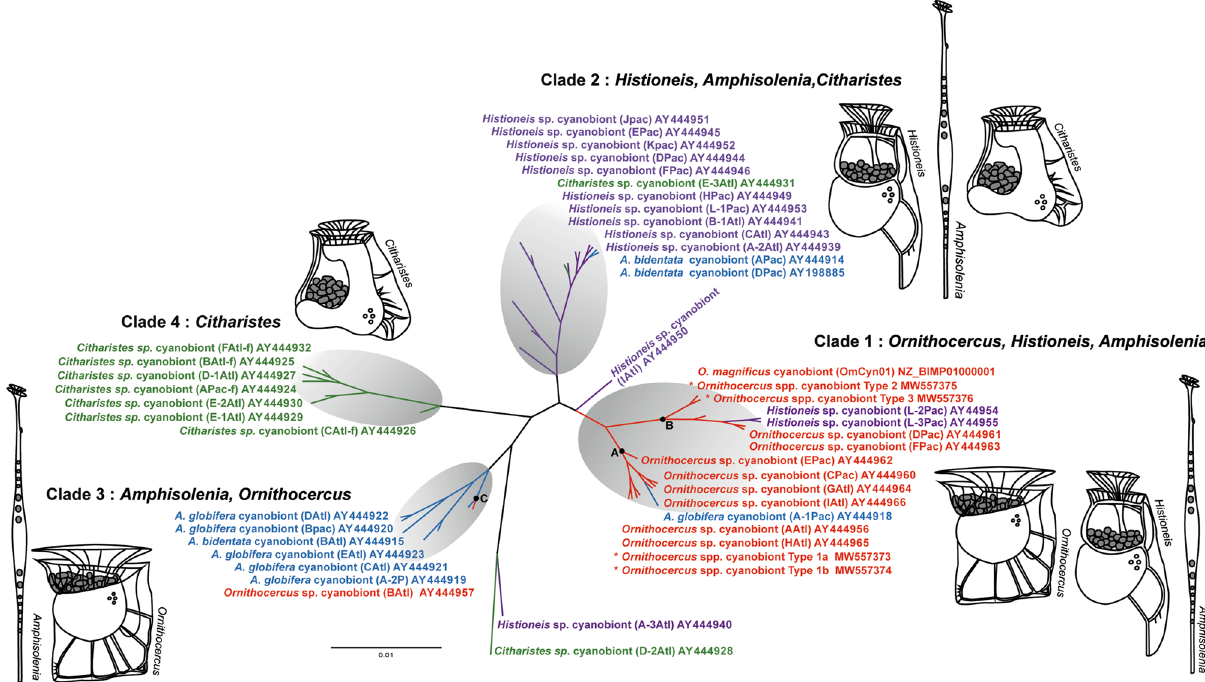
Figure 7. Phylogenetic clustering of dinoflagellate hosting-cyanobionts. A maximum Likelihood tree based on the V3–V4 regions of the cyanobacterial 16S rDNA gene was inferred using IQ-TREE under the TN + F + R2 model. Each host genus with cyanobionts (grey) is illustrated. Different colors of text and lines represent each host genus. Capital letters indicate the genetic clade of Ornithocercus mentioned in Fig.